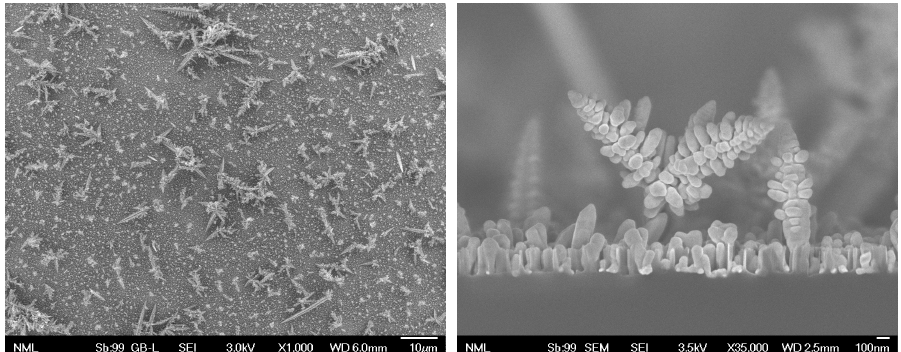
Figure 2. SEM micrographs of Ag-dendrites grown on SiNWs on a Si substrate, ( left ): top view (scale bar: 10 µ m), ( right ): cross section (scale bar: 100 nm).